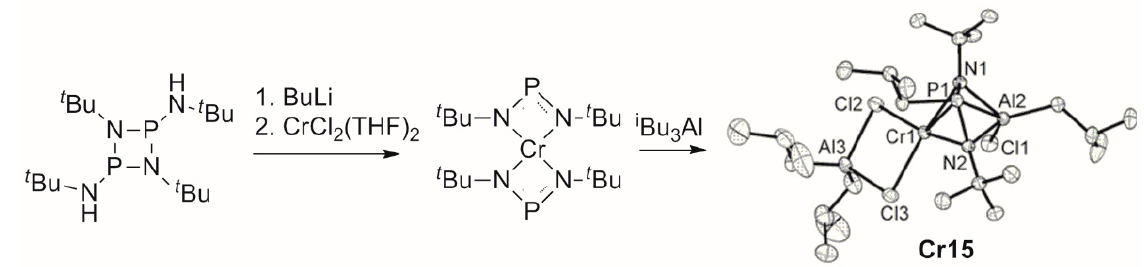
Figure 32. Preparation and molecular structure of complex Cr15 . Reprinted with permission from [250]. Copyright (2008) Wiley-VCH Verlag GmbH & Co. HN(CH 2 CH 2 PPh 2 )- and HN(CH 2 CH 2 SR) 2 -based Cr(II) and Cr(III) chloro complexes